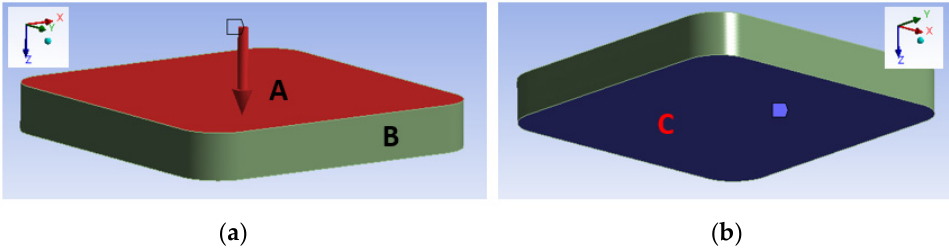
Figure 11. Boundary conditions for the mechanical problem: ( a ) the pressure is applied to surface A (depicted in red); surfaces A and B are fixed in the x and y direction; ( b ) surface C is fixed in the z direction (depicted in blue).